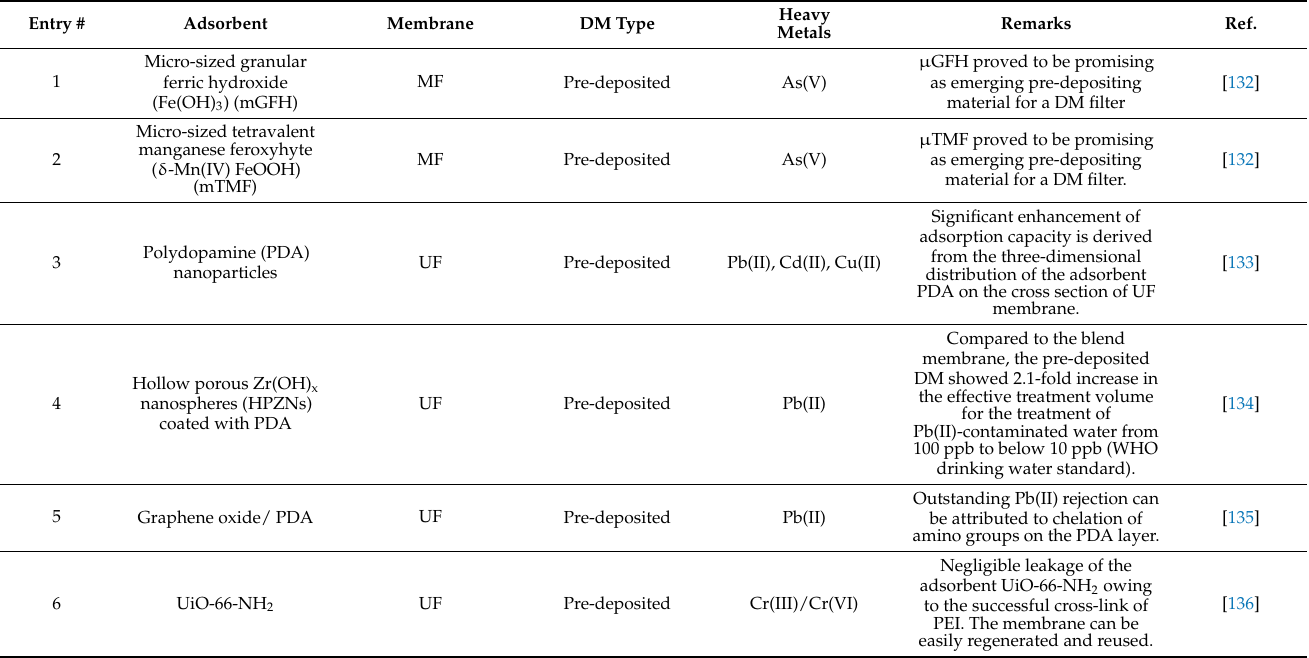
Table 4. Characteristics of some studies on adsorptive